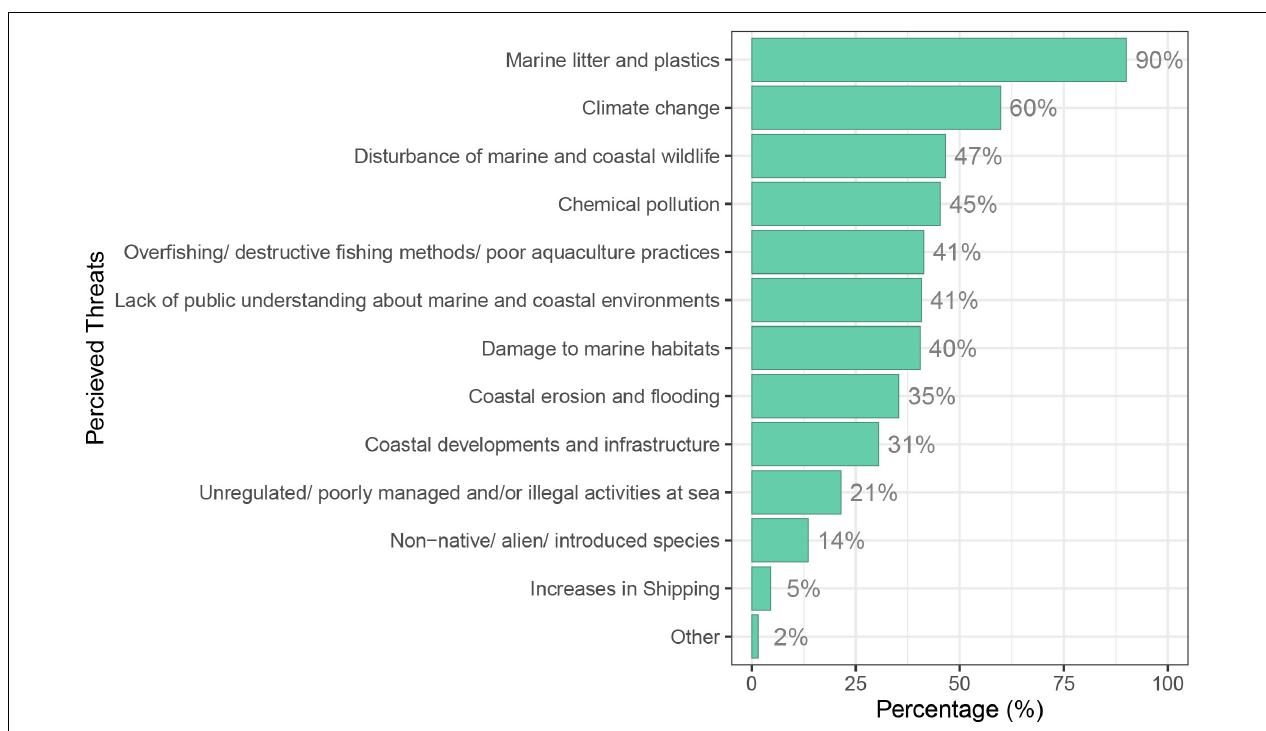
FIGURE 3 | Commonly perceived threats to the Fife marine and coastal environment ( n =